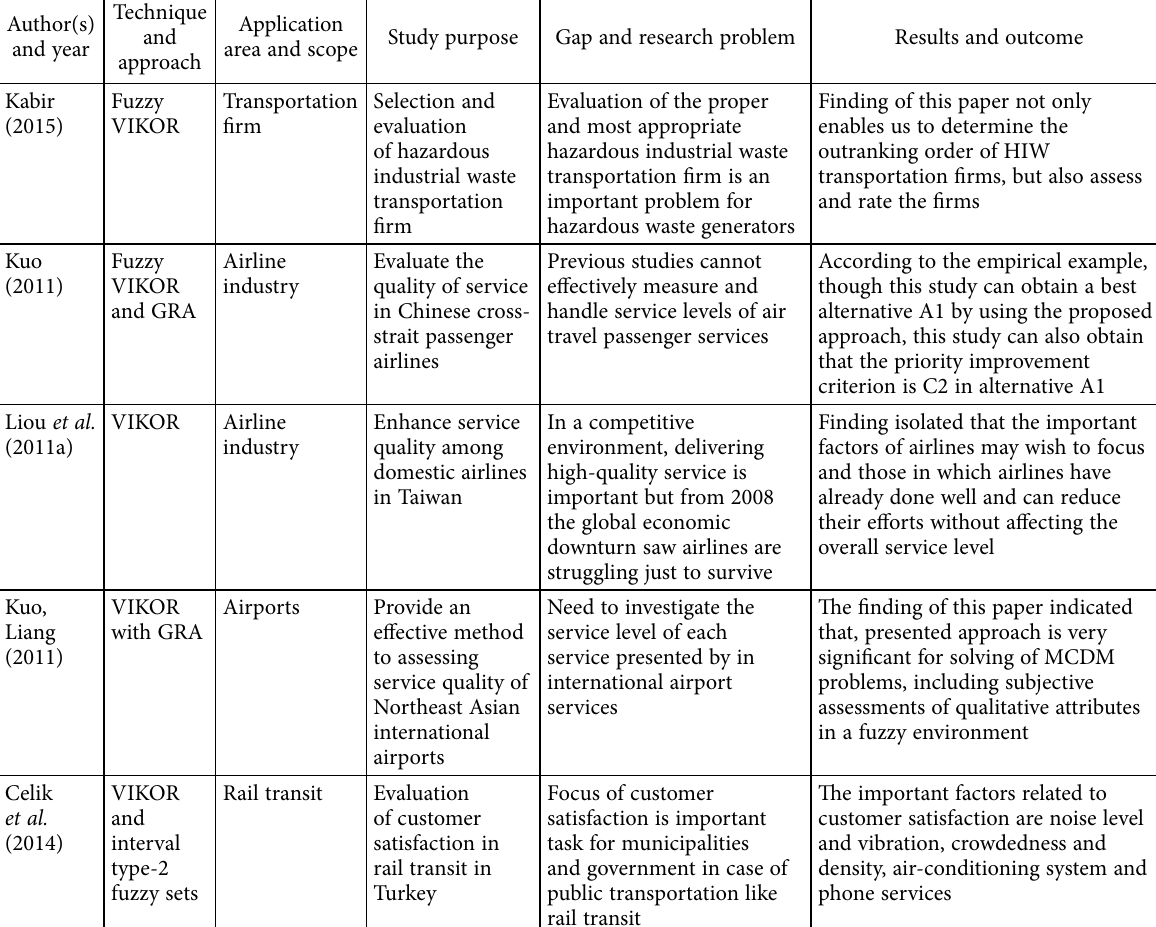
Table 8. Distribution based on VIKOR and Fuzzy VIKOR with other